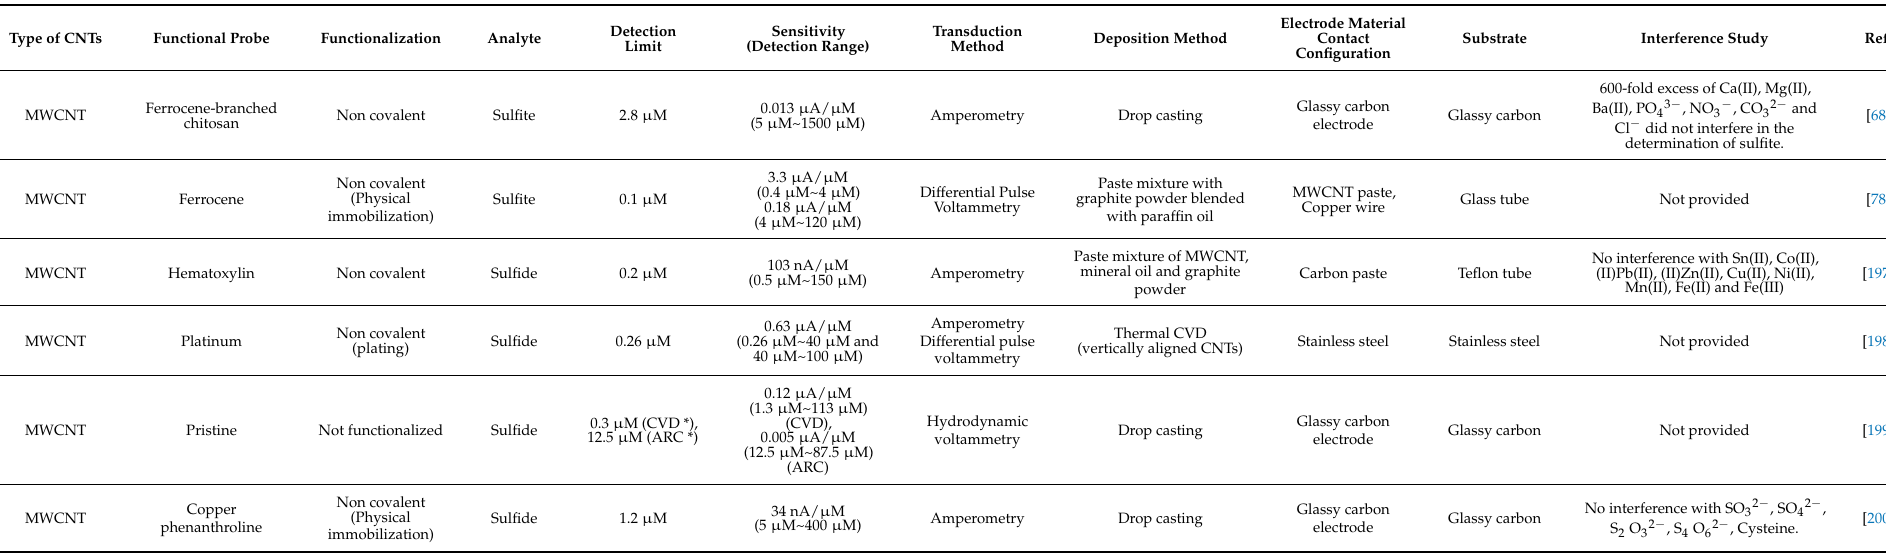
Table 15. CNT-based sulfur sensors for water quality monitoring. References are sorted by analyte (sulfite and sulfide), then by limit of